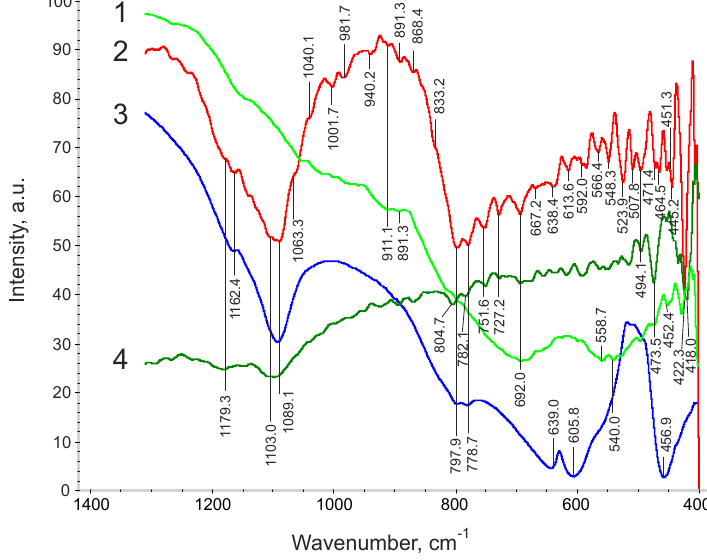
Figure 5. FTIR spectrum in the frequency range of 400 – 1300 cm − 1 : ( 1 ) MgAl 2 O 4 ; ( 2 ) TiB 2 composite 25 wt % of MgAl 2 O 4 ; ( 3 ) gray corundum; ( 4 ) TiB 2 . FTIR spectrum of composite (TiB 2 + 25 wt % of MgAl 2 O 4 ) consists of numerous absorption bands typical for titanium diboride, spinel, and corundum (pattern 2).